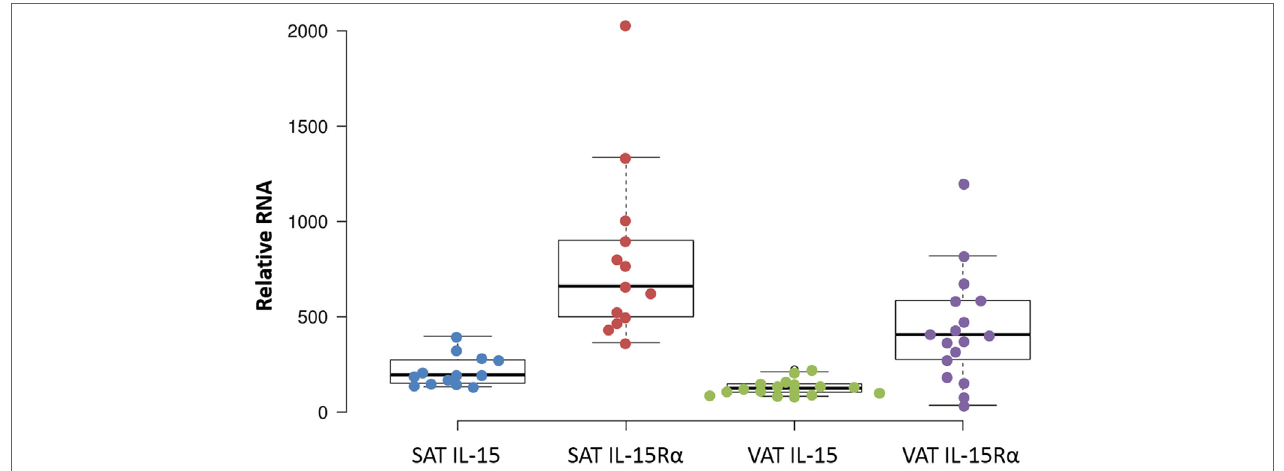
FigUre 2 | IL-15 and IL-15R α RNA are produced in both subcutaneous adipose tissue (SAT) and visceral adipose tissue (VAT). Except for one sample, all cohort B SAT samples were from females, from surgeries for panniculectomy (7), ventral hernia (1), breast reduction (4), and mastectomy (1). VAT subjects had surgeries for hernia repair (1), nephrectomy (3), colectomy (12), and gastrectomy (1). Cohort B is described in Table S1 in Supplementary